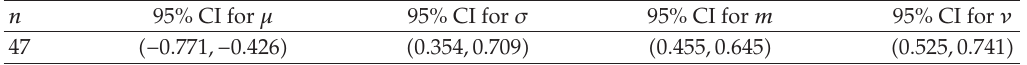
Table 7: Grouped data: τ 1 (cid:8) − 0 . 71 , τ 2 (cid:8) − 0 . 61 , τ 3 (cid:8) − 0 . 41 , τ 4 (cid:8) − 0 . 21 , τ 5 (cid:8) 0 . 11